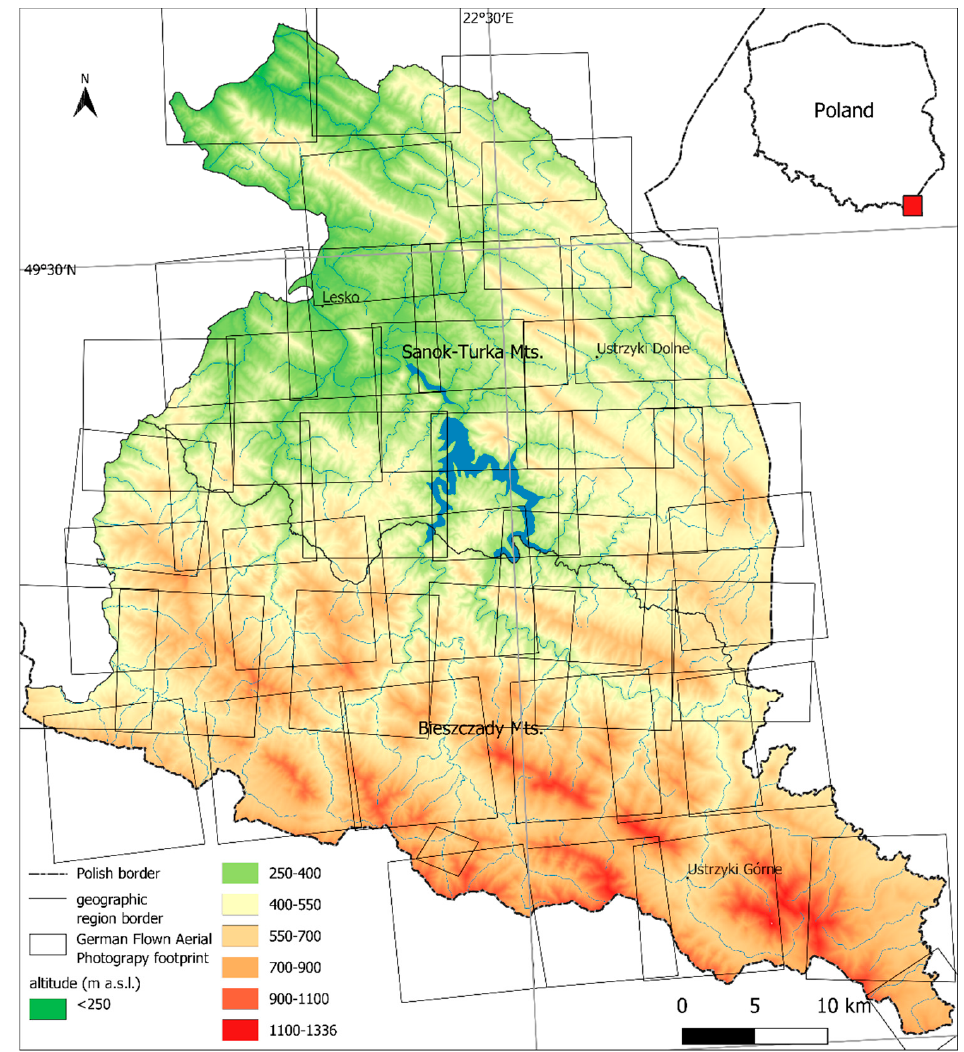
Figure 1. Study area—the Polish Eastern Carpathians with footprints of German Flown Aerial Photographs. Borders of geographic regions according to [37].